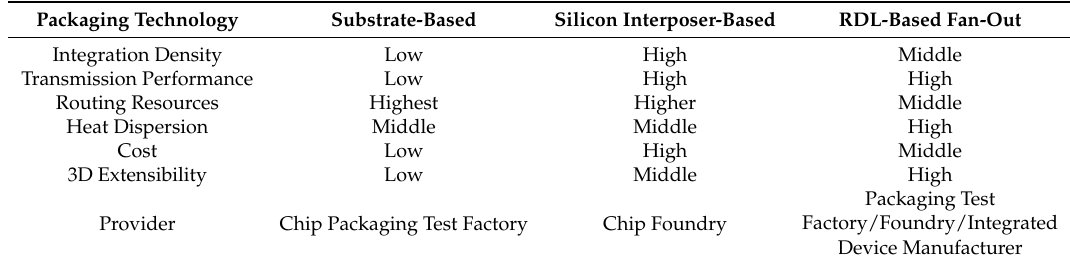
Table 4. Comparisons of Chiplet Packaging